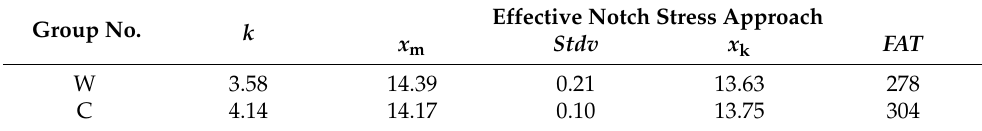
Table 7. Statistical estimation of fatigue strength.